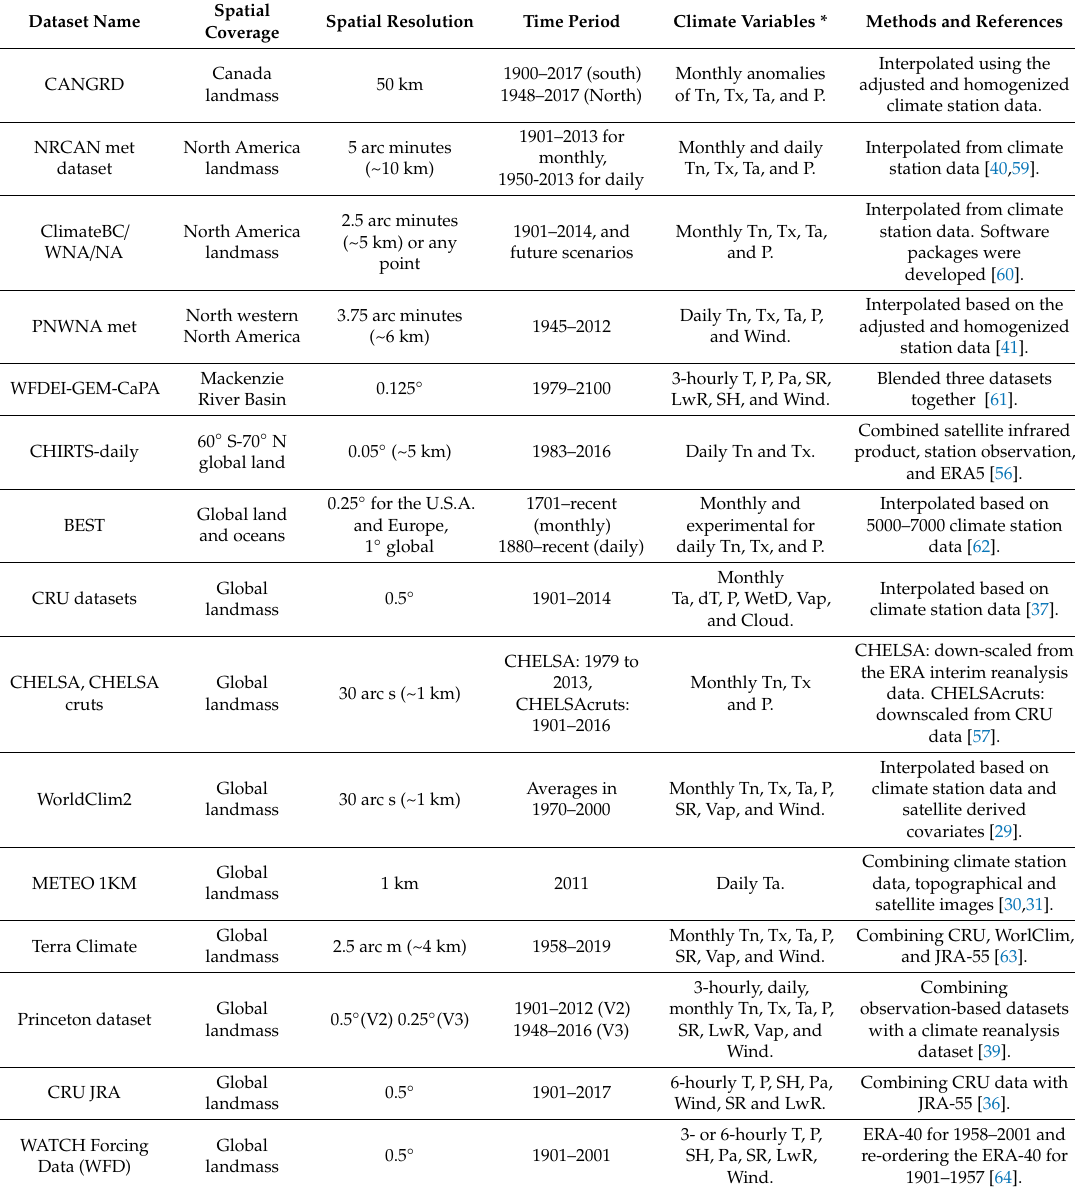
Table A1. A list of the gridded historical meteorological datasets covering Canada (Pure model reanalysis data are not included except for the datasets that cover the periods before the